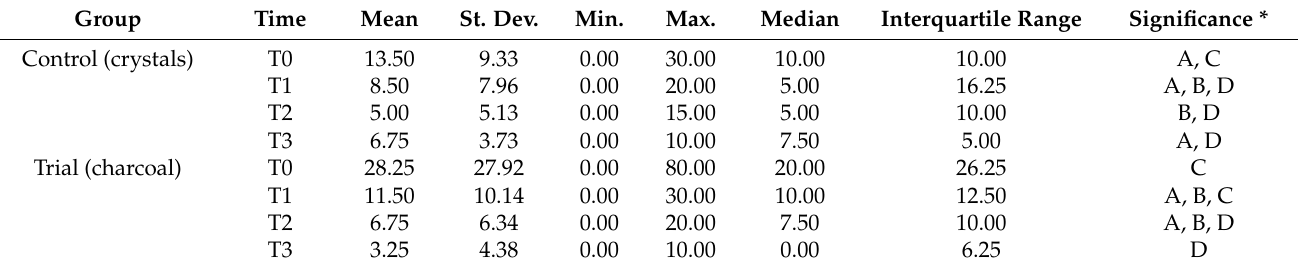
Table 5. Descriptive statistics of BoP, and significant intragroup and intergroup differences